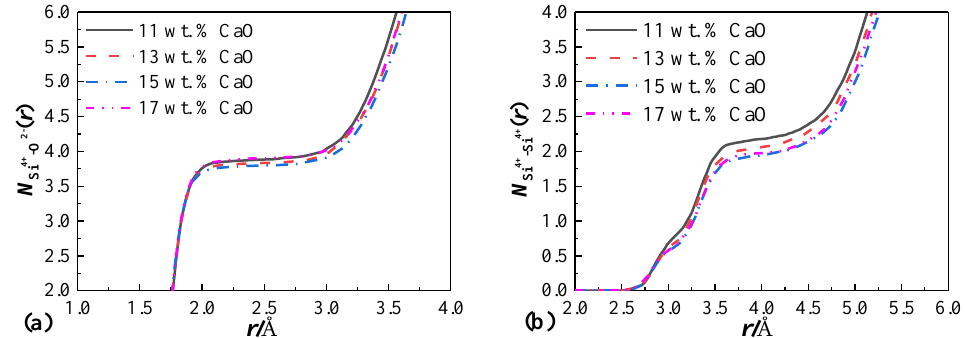
Figure 5. Coordination number of ion pairs in nickel slag with di ff erent contents of CaO at 1150 ◦ C ( a ) Si 4 + -O 2 − coordination number; ( b ) Si 4 + -Si 4 + coordination